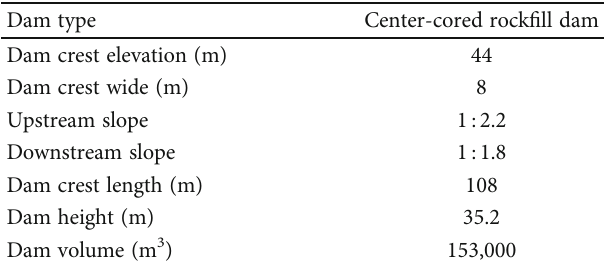
Figure 1: Management stage of fi ll dams [4]. Table 1: Summary of the dam for